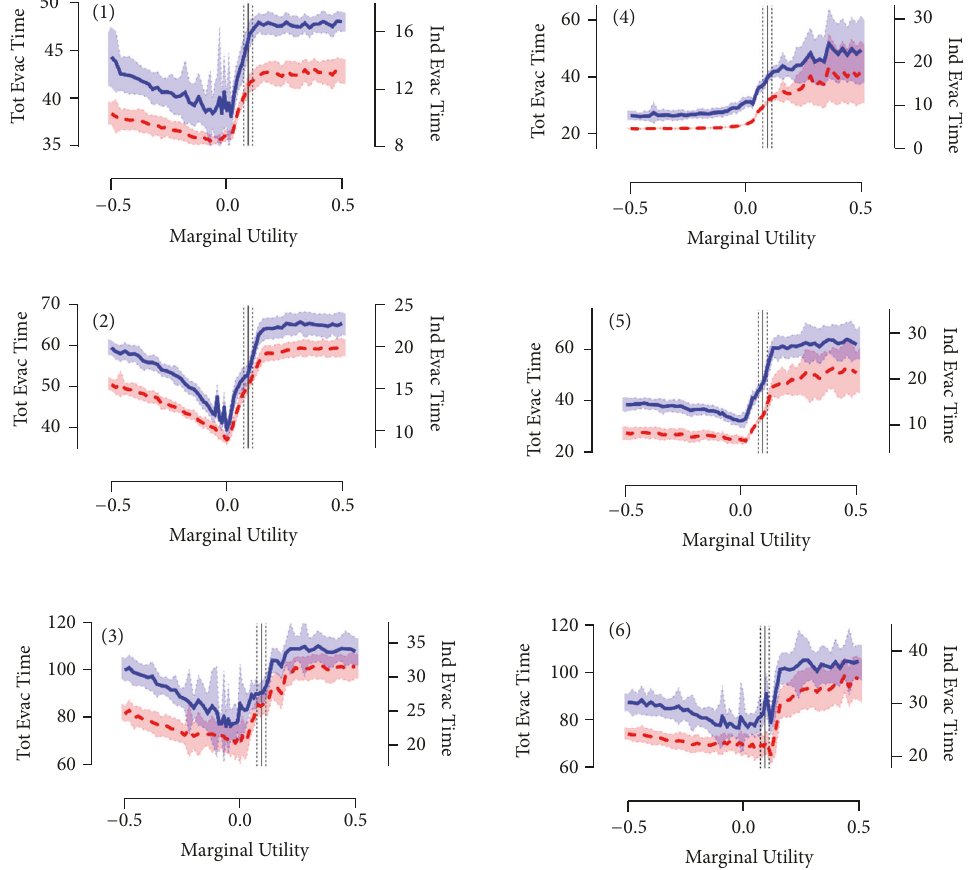
Figure 13: Variations of the simulated total evacuation times (blue solid lines; left vertical axis) and simulated average individual evacuation times(reddashedlines;rightverticalaxis)asaresultofchangesinthemarginalutilityofVISattributeinexitdecision-makingofthesimulated evacuees. Error bands show the standard deviations of the measurements. The vertical solid lines represent the empirically estimated value for the marginal utility of VIS, and the vertical dashed lines visualise the 95% confidence interval of that